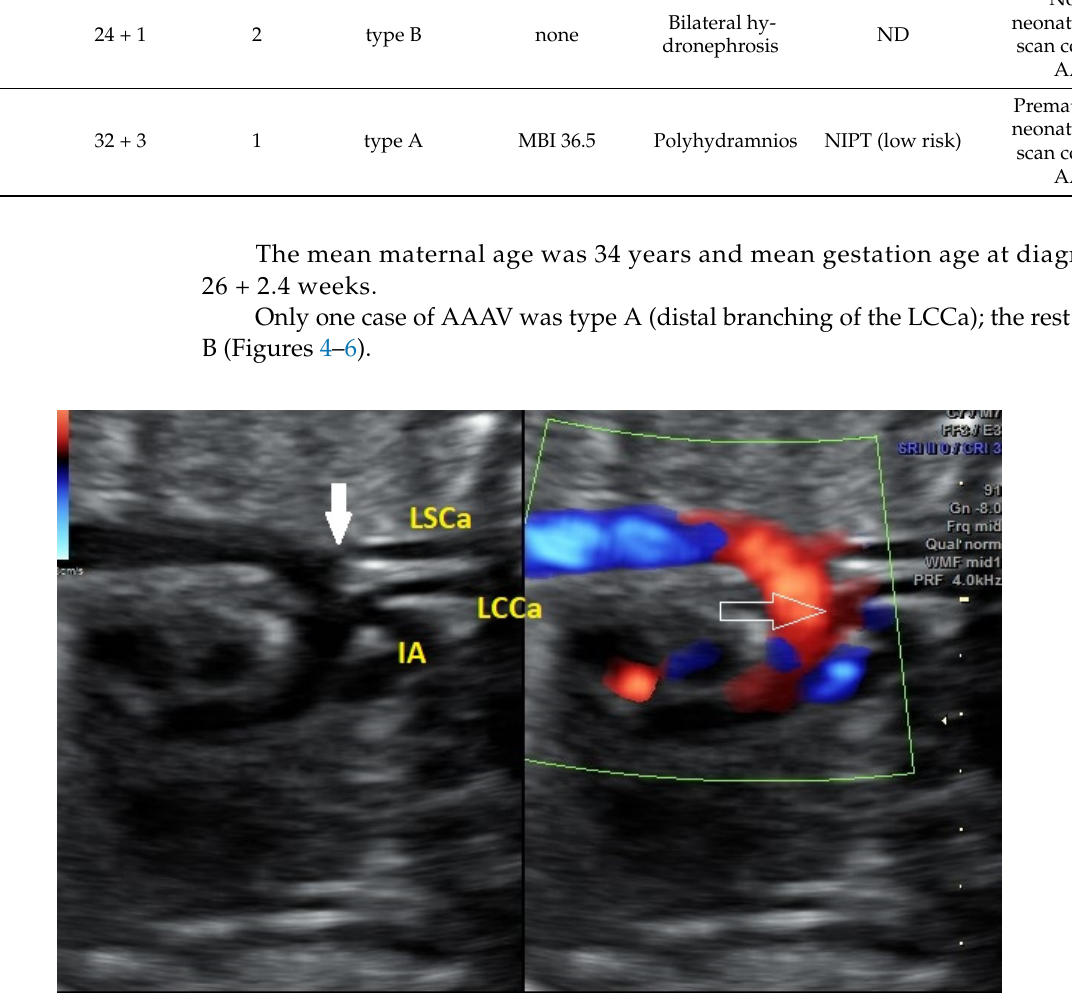
Figure 4. AAAV type B at 21 weeks, B mode and Doppler colour side by side. Note the common origin of IA and LCCa.